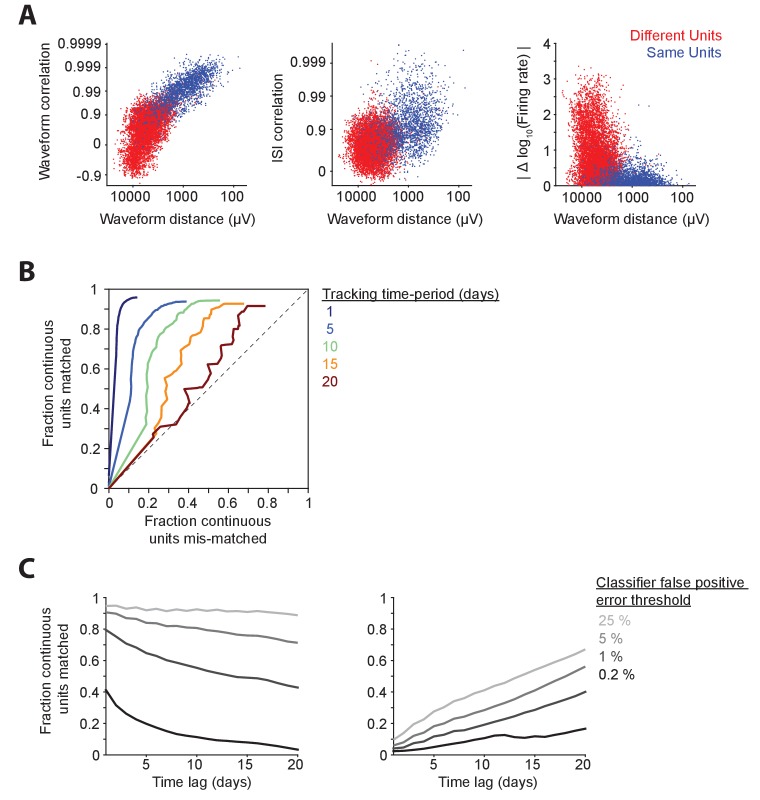
Benchmarking the performance of discontinuous unit-tracking methods using continuous long-term datasets sorted by FAST.(A) Discontinuous tracking of units across daily recording sessions is error-prone. Similarity metrics between units isolated on consecutive days in hour-long recording sessions (data from an example DLS recording). Three out of six possible combinations of similarity features are presented here – spike waveform correlation (left), inter-spike interval histogram (ISI) correlation (middle) and absolute log firing rate difference (right) versus spike waveform Euclidean distance. Each dot represents the similarity between pairs of units recorded on the same tetrode and classified as the ‘same’ (blue dot) or ‘different’ (red dot) by our FAST algorithm. (B) Receiver-operator characteristic (ROC) curves for discontinuous tracking of units over time-periods of 1, 5, 10, 5 and 20 days. Each ROC curve was generated by systematically varying the desired false-positive error rate of a ‘same’ versus ‘different’ optimal linear classifier from 0% to 100%. Line colors indicate different tracking time-periods as per the plot legend. Note that the discontinuous tracking algorithm (see Materials and methods) matches pairs of units across days in order of their similarity, with highest similarity pairs being matched first. Due to this, the fraction of units mis-matched (false positive error rate of unit tracking) does not reach 100% even when the desired false-positive error rate of the ‘same’ v/s ‘different’ classifier is set to 100%. (C) (Left) Percentage of ‘same’ unit pairs identified by the FAST method that were successfully matched by discontinuous tracking at 1 day intervals, over time-periods ranging from 1 to 20 days. (Right) Percentage of discontinuously matched unit pairs that are classified as ‘different’ by FAST for time-periods ranging from 1 to 20 days. Graded colors correspond to different false positive rate thresholds of the ‘same’ versus ‘different’ optimal linear classifier (see Materials and methods) ranging from 0.2% (light gray) to 25% (black).